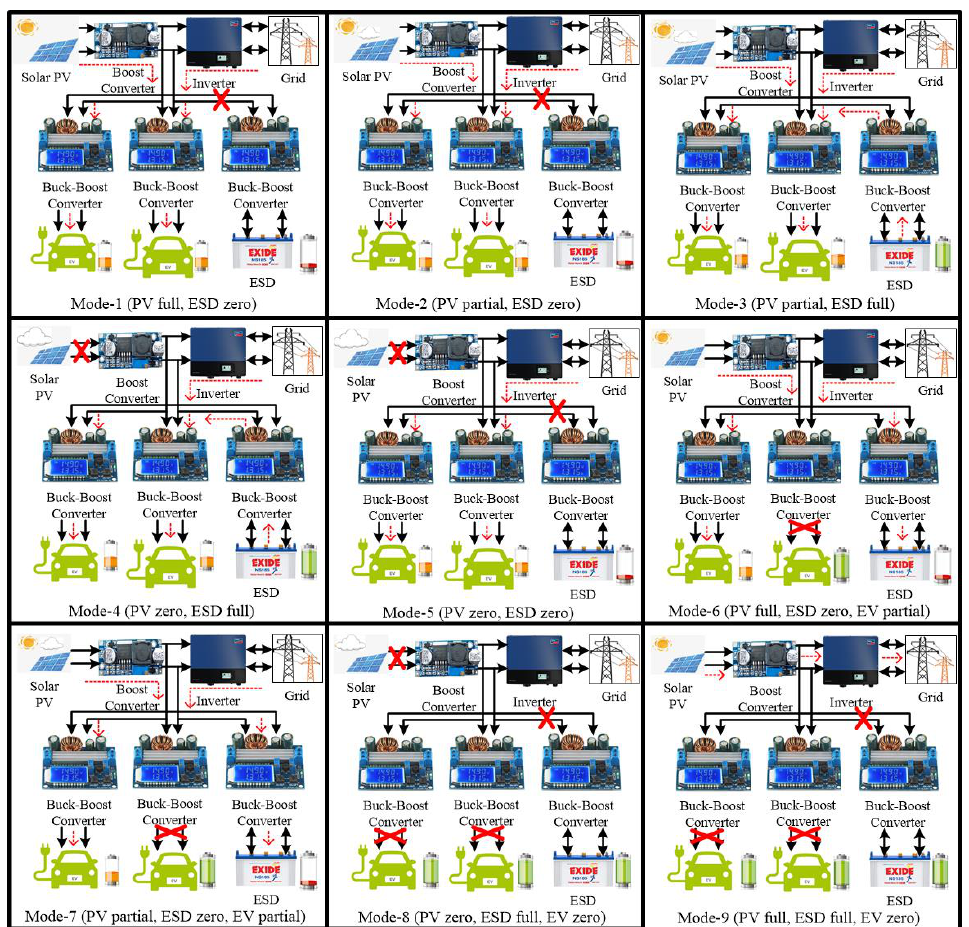
Figure 9. Modes of operation for GCPE charging architecture with an ESD and iEMS.